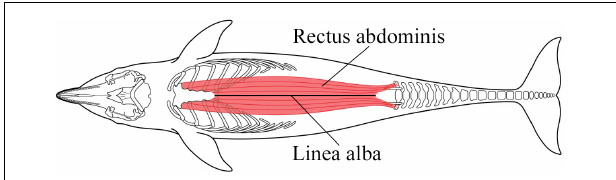
FIGURE 7 | In bottlenose dolphins each rectus abdominis muscle stretches from the sternal ribs and sternum to the pelvic bones and transverse processes of caudal vertebrae (Cotten et al., 2008). Each muscle is enveloped by the rectus sheath, formed by aponeuroses of the external and internal abdominal oblique and transverse abdominal muscles (Schaller et al., 2007). The fibers of the internal and external laminae wrap around the rectus muscles and intertwine with the contralateral fibers along the ventral midline, forming the linea alba . Figure adapted from Cotten et al. (2008) and Cozzi et al.